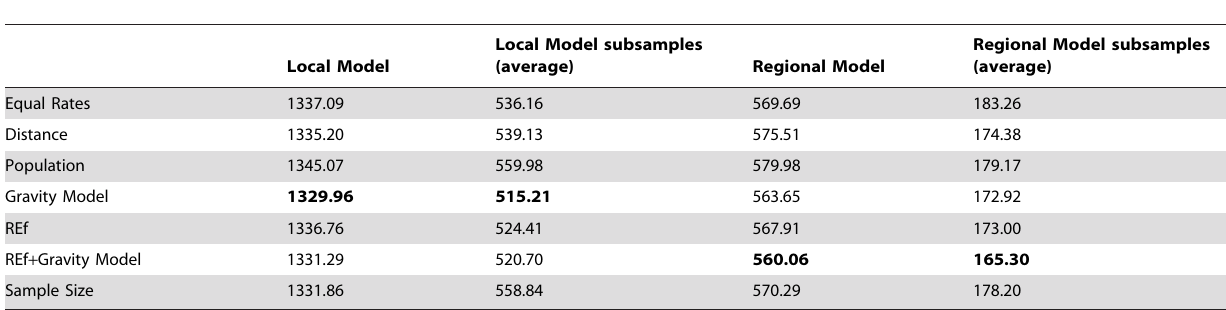
Table 3. Marginal log likelihood estimates for the fit of different phylogeographic models using